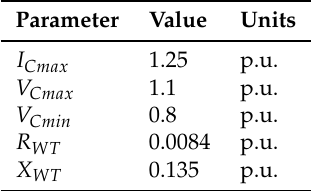
Table 1. Parameters used to plot reactive power capability of WT.